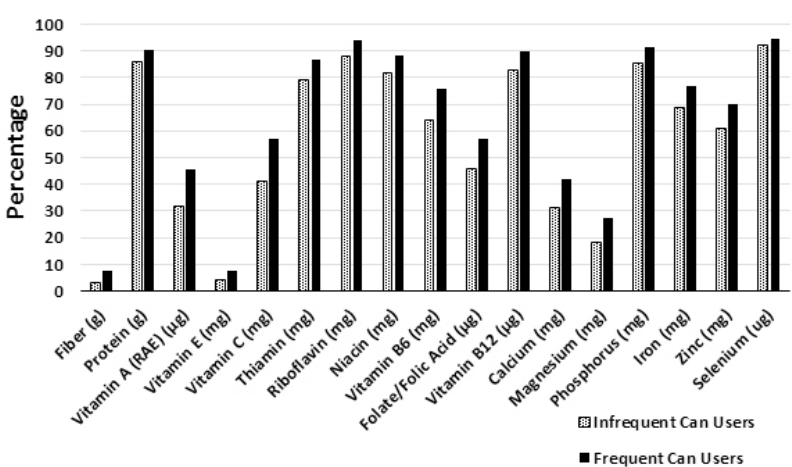
Figure 3. Percentage of days in which participants met or exceeded the Recommended Dietary Allowance (RDA) for different nutrients among Frequent and Infrequent Canned Food Users (FCU and ICU). Percentage of infrequent ( n = 2732) and frequent ( n = 2584) canned food users survey days in which the RDA was met or exceeded for a nutrient. Data from the National Purchase Diary (NPD) Group’s National Eating Trends ® intake diary panel 2011–2013 and Nutrient Intake databases. Statistical confidence level set at 95% for two-tailed t test. p -Value < 0.025% considered significant. The FCU group had significantly higher values for all nutrients listed ( p ≤ 0.02). Table 3. Percentage of Canned vs. Non-Canned consumption days in which participants met or exceeded the Recommended Dietary Allowance (RDA) for a nutrient among Frequent and Infrequent Canned Food Users.